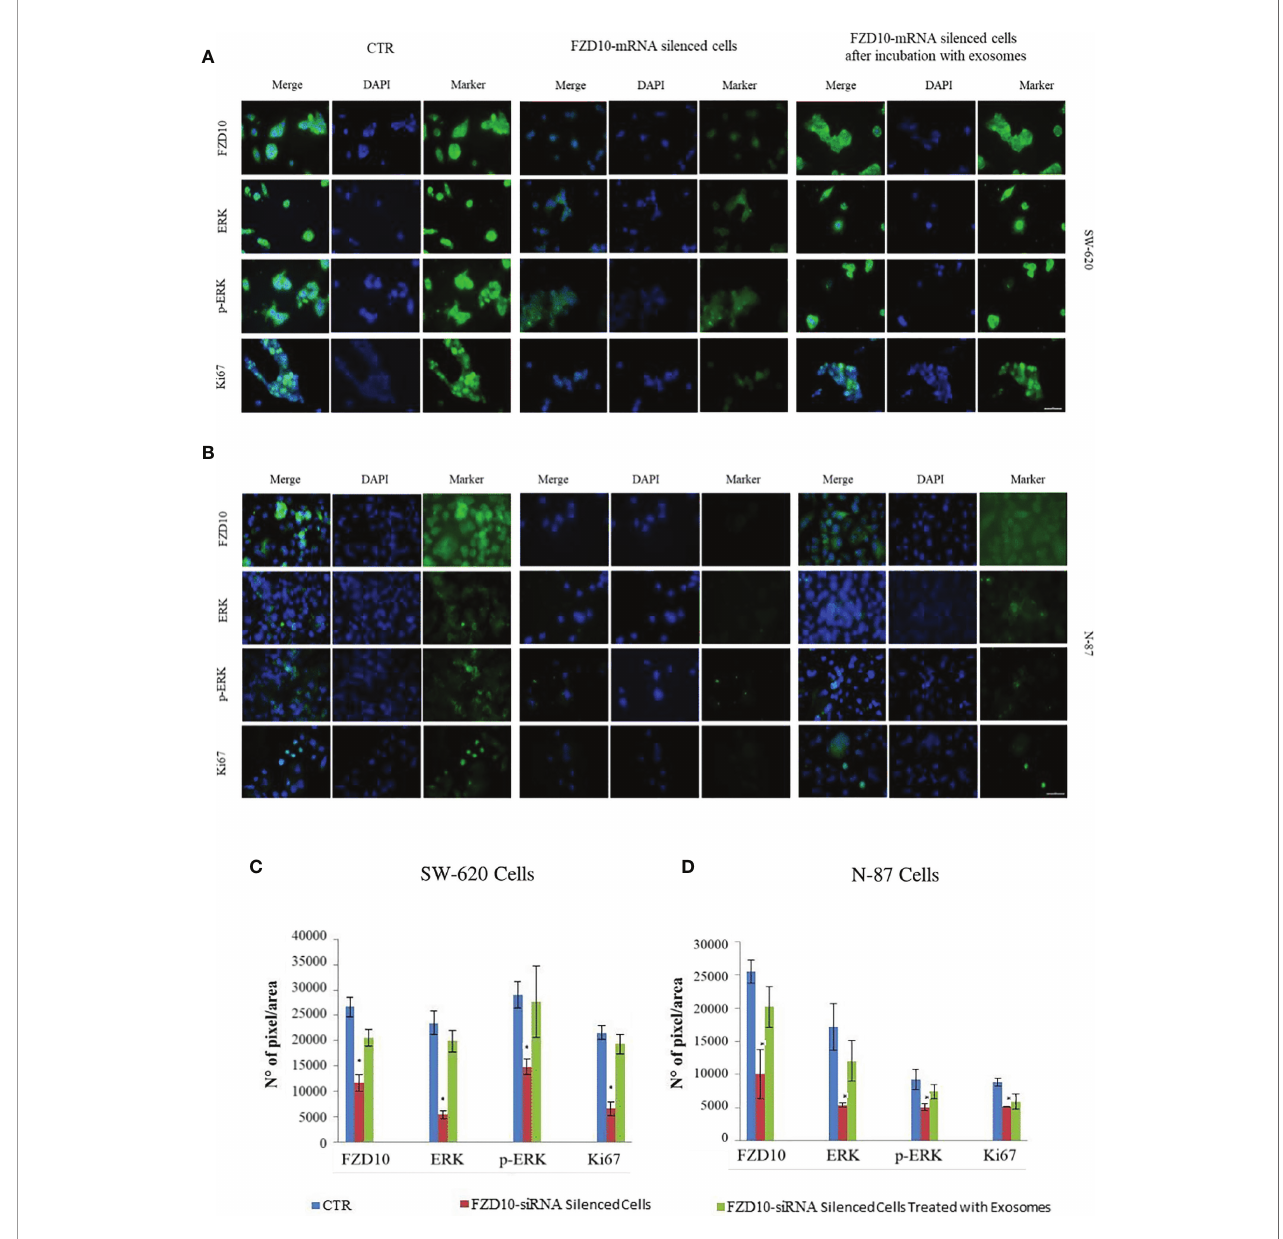
FIGURE 8 | Detection of Frizzled (FZD)10, extracellular signal-regulated protein kinase (ERK), p-ERK, and Ki-67 by immuno fl uorescence confocal microscopy in fi xed SW620 (A) and N87 (B) cells. Confocal microscopy images and immuno fl uorescence by mean intensity index of FZD10-mRNA silenced SW620 (A, C) and FZD10-mRNA silenced N87 (B, D) cells before and after incubation with corresponding exosomes. For each cell line, cells treated only with the si-PORT-NeoFX transfection agent were used as negative control (CTR). Blue channel: nuclei; green channel: labeled respectively FZD10, ERK, p-ERK, and Ki-67; merge: overlay of blue and green channels. Scale bar, 20 µm. (*) p <